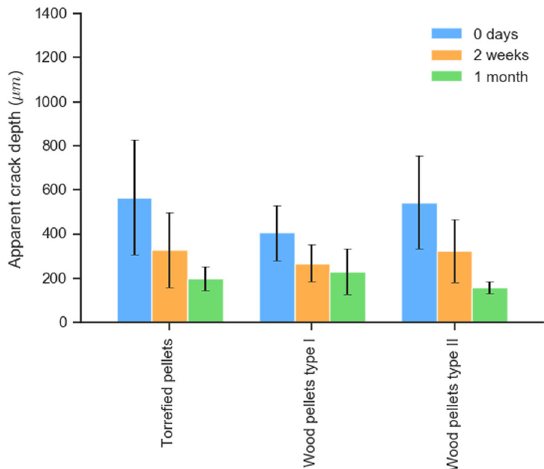
Fig. 3 Mean apparent depth of the cracks observed at the surface of biomass pellets at 0 days, 2 weeks, and 1 month after storage. Light blue, orange, and green bars represent the apparent crack depth per type of pellet in μ m for 0 days, 2 weeks, and 1 month, respectively. The error bars represent the standard